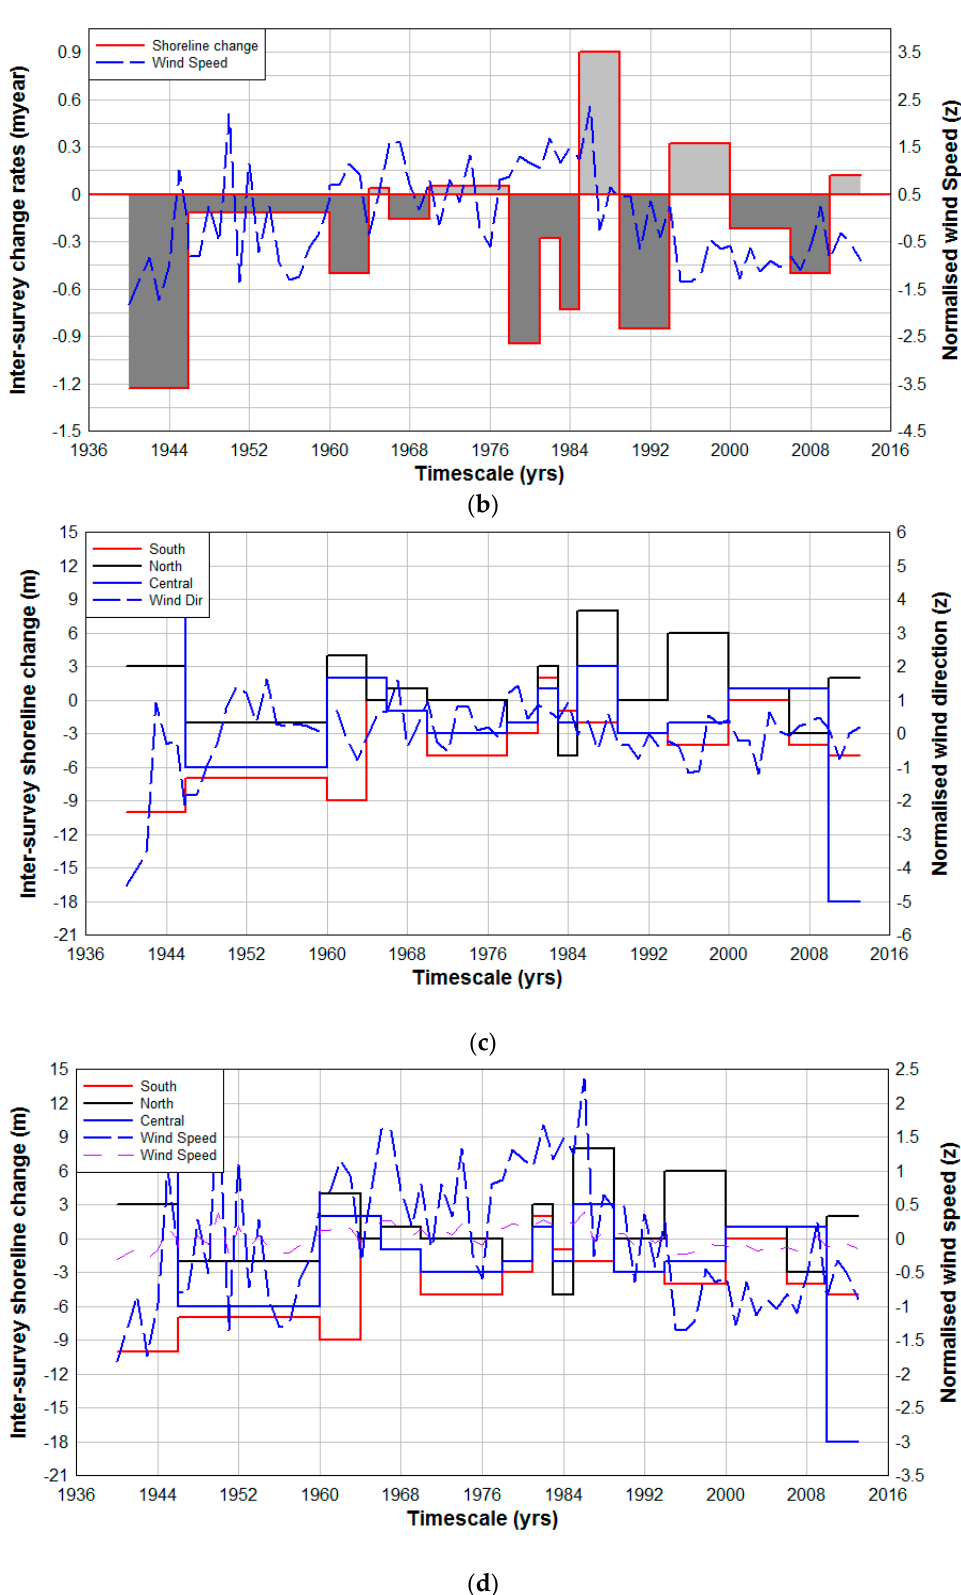
Figure 11. Comparison of Shoreline change rates (Table 2) and normalized ( a ) wind direction in degrees clockwise from true north; ( b ) wind speed and comparisons of average inter-survey shoreline changes by beach sector, with normalized ( c ) wind direction and ( d ) wind speed for the period 1941–2014. Note: dark grey and negative shoreline change values = erosion and light grey and positive shoreline change values = accretion.